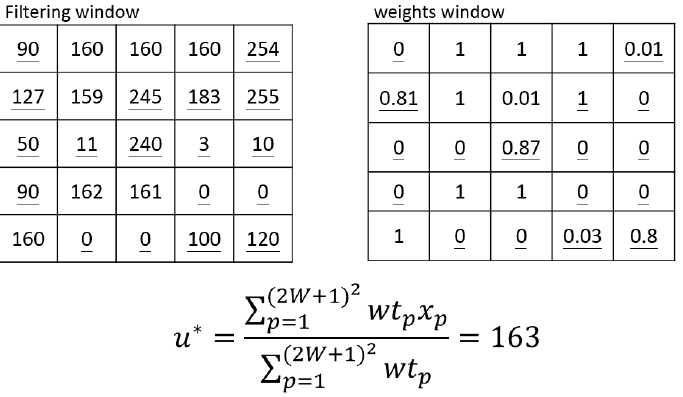
Figure 6. Pixel value of high noise restoration ( u * = 163).